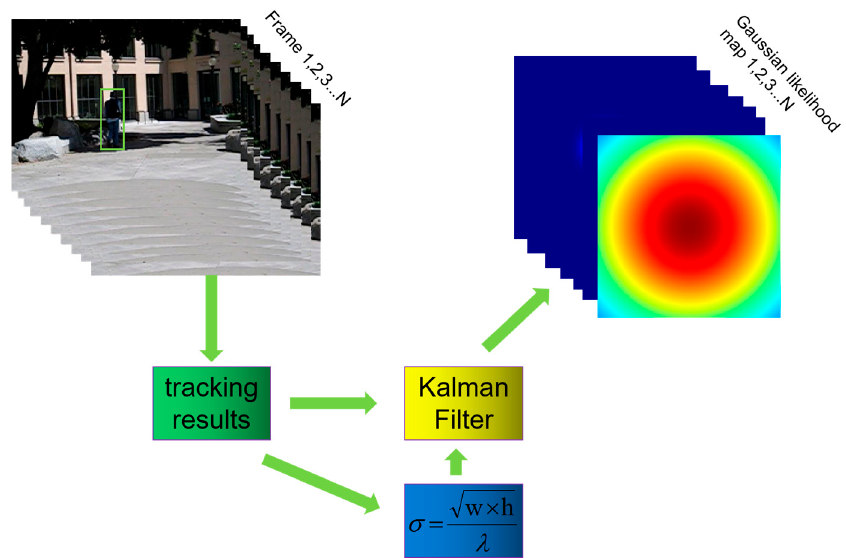
Figure 4. Workflow of using Kalman filter to generate Gaussian likelihood maps. The green rectangle in Frame 1 is the ground-truth bounding box containing the right target.